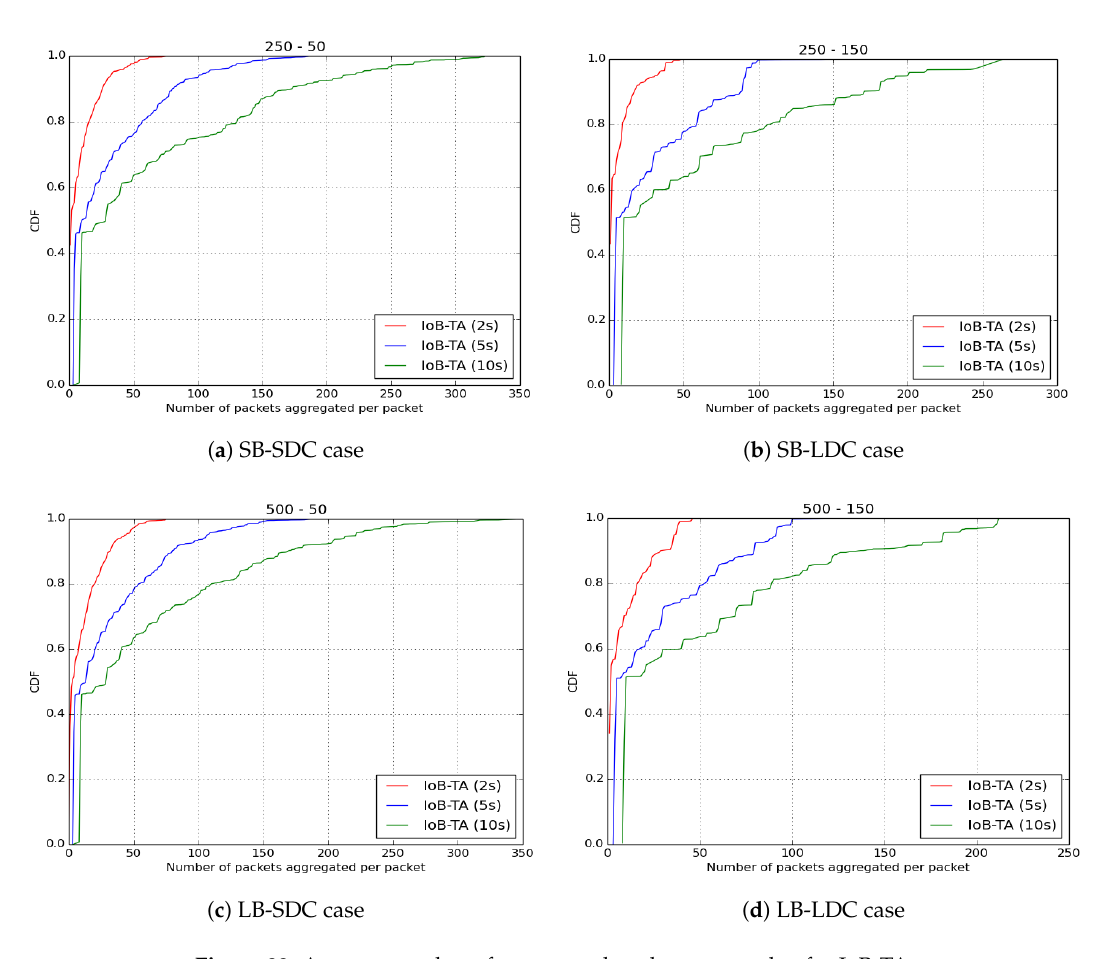
Figure 33. Average number of aggregated packets per packet for